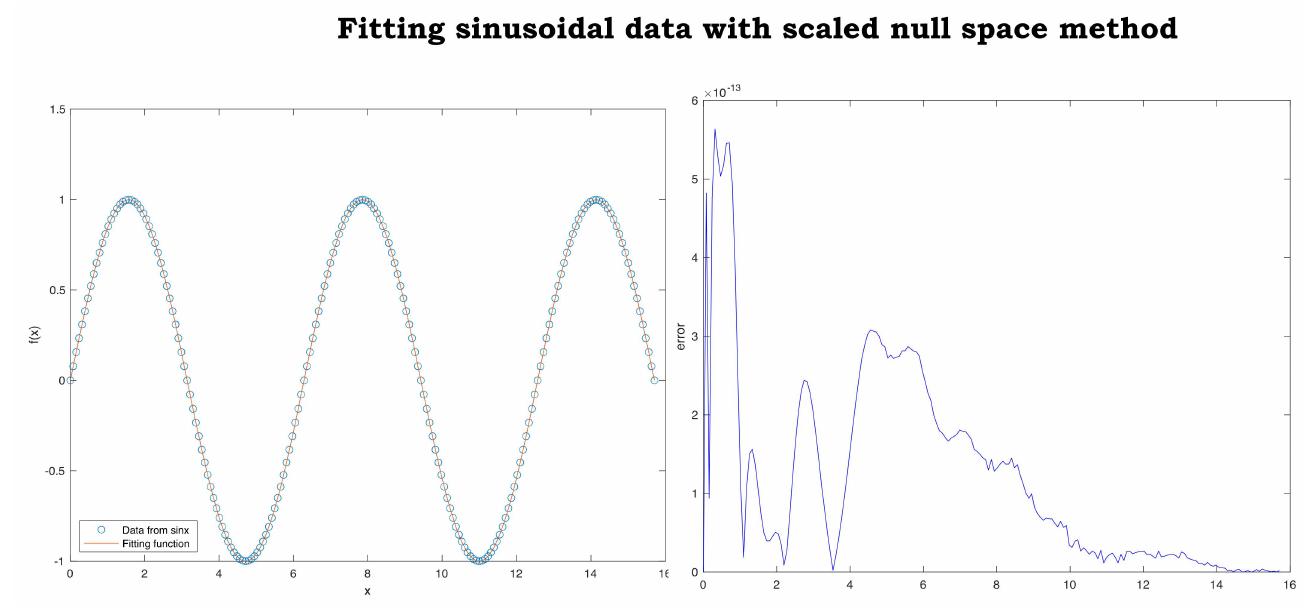
Figure 10. Fitting discrete sample of 201 uniformly selected datapoints from sine function over [ 0, 5 π ] with scaled null space method. Residual errors range from 0 to 5.6377 × 10 − 13 , and polynomials have degree N =